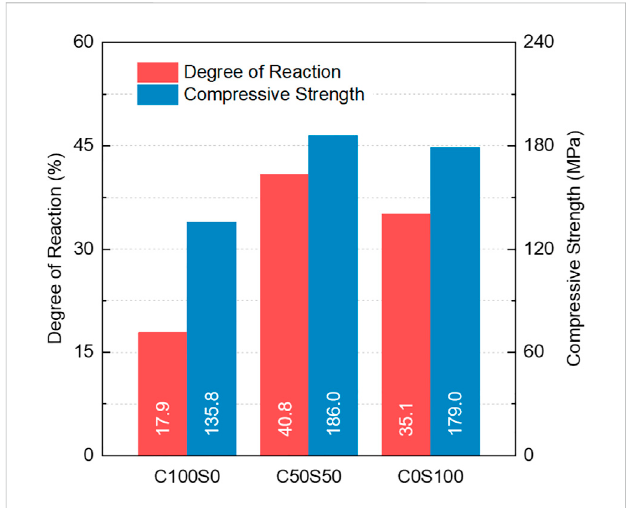
FIGURE 6 Reaction degrees of SH-UHPGC pastes with different